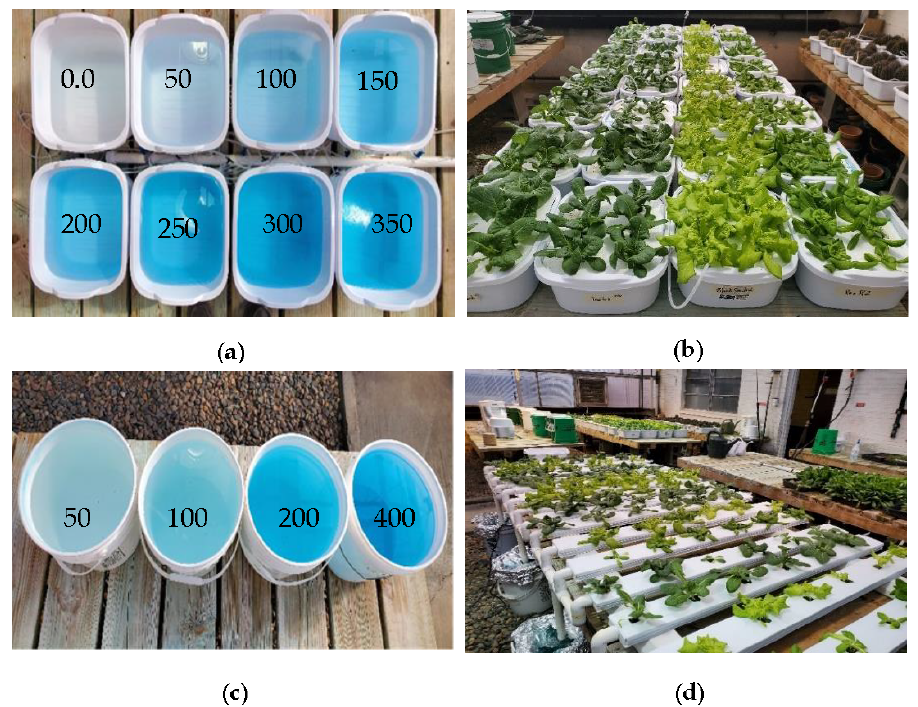
Figure 1. ( a ) Nutrient solutions in different concentrations, ppm; ( b ) four lettuce cultivars, including Parris, Tacitus, Black Seed Simpson, and Rex (left to right), grown in hydroponic tubs; ( c ) nutrient solutions in different concentrations, ppm; ( d ) four lettuce cultivars, including Parris, Black Seed Simpson, Rex, and Tacitus (left to right), grown in the NFT system for ten days.